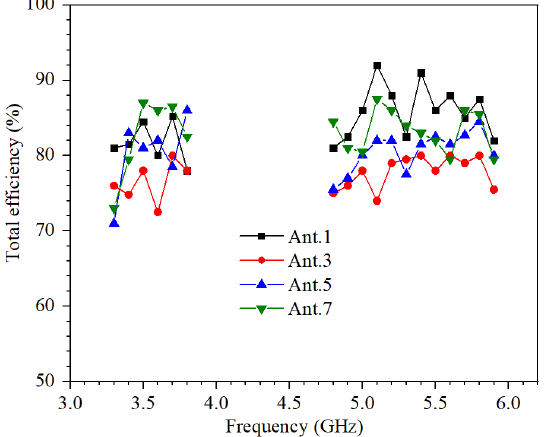
Figure 7. Measured total efficiencies of Ant. 1,2,3,4.